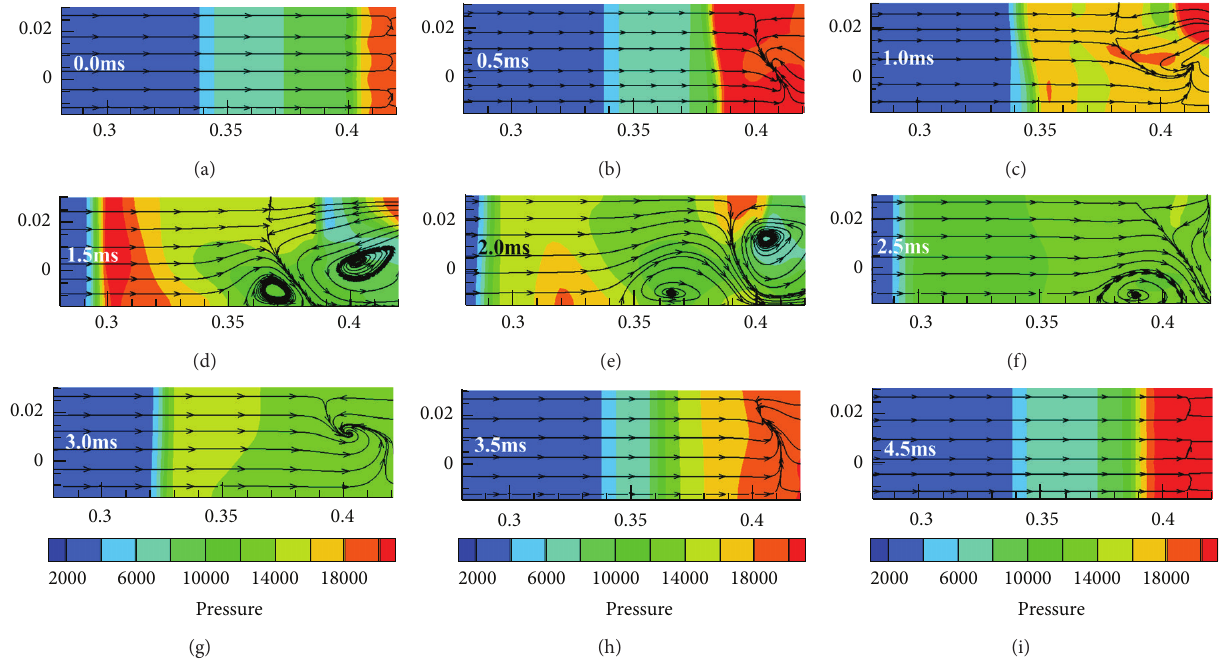
Figure 9: Static pressure contours mixing with streamlines of cross section 𝑌 in a buzz